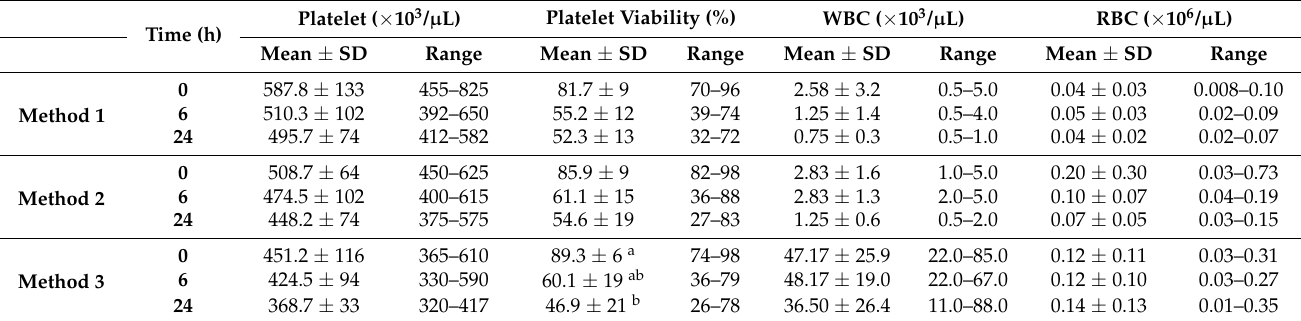
Differences within column superscripts ( a,b ) indicate differences between groups ( p <